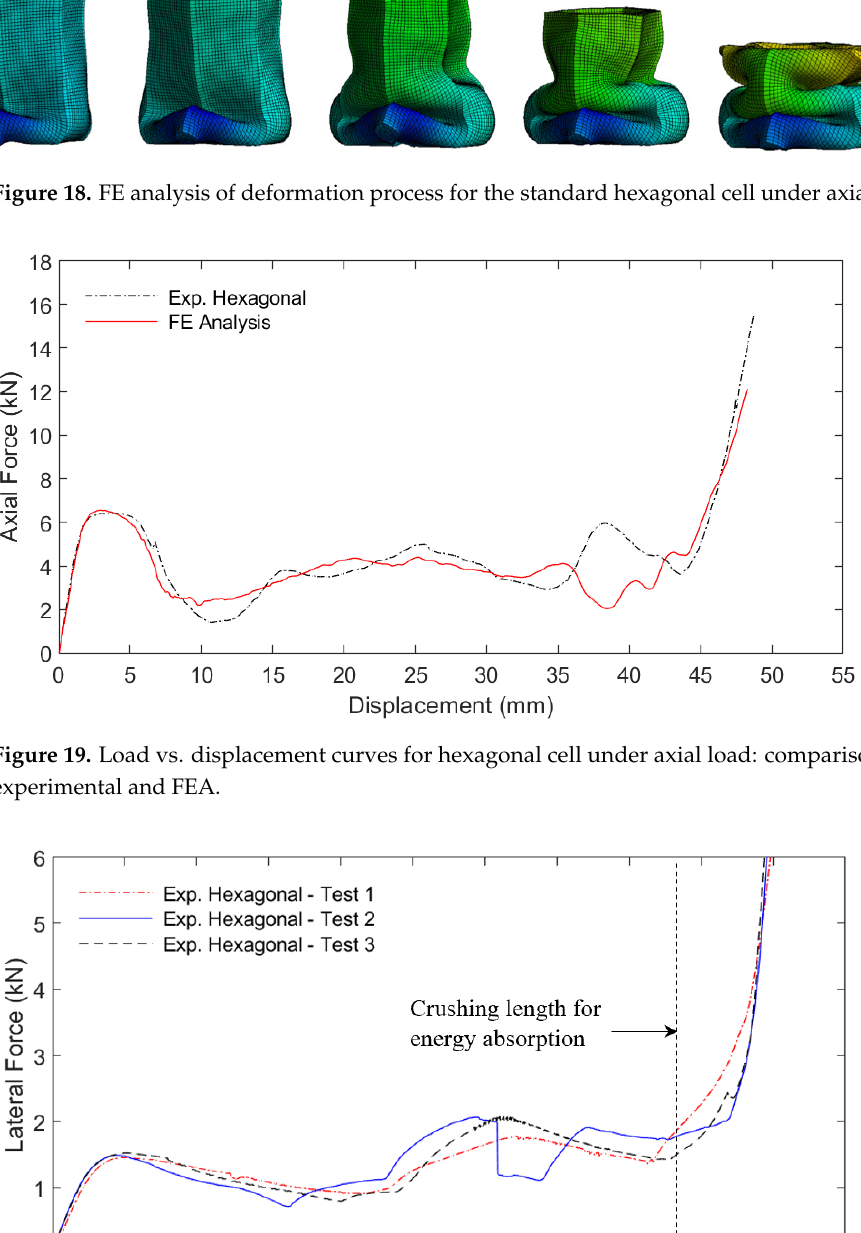
Figure 21. Experimental compression test of standard hexagonal cell under lateral load.